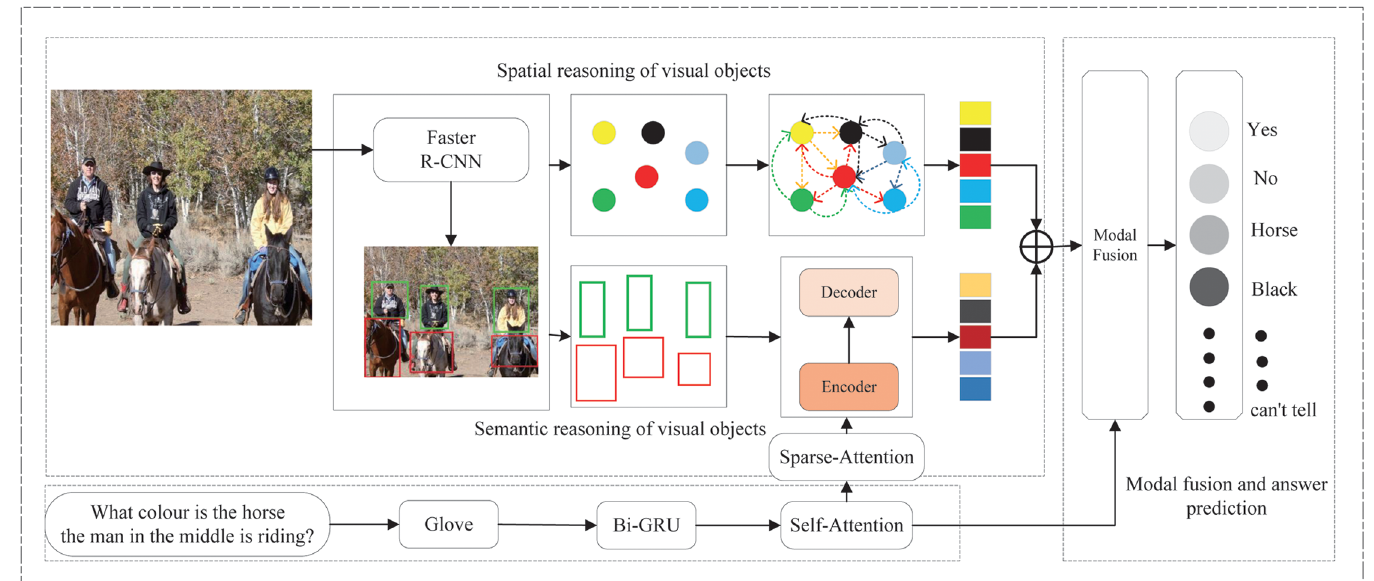
Fig 2. Overall flowchart of the proposed SRRN